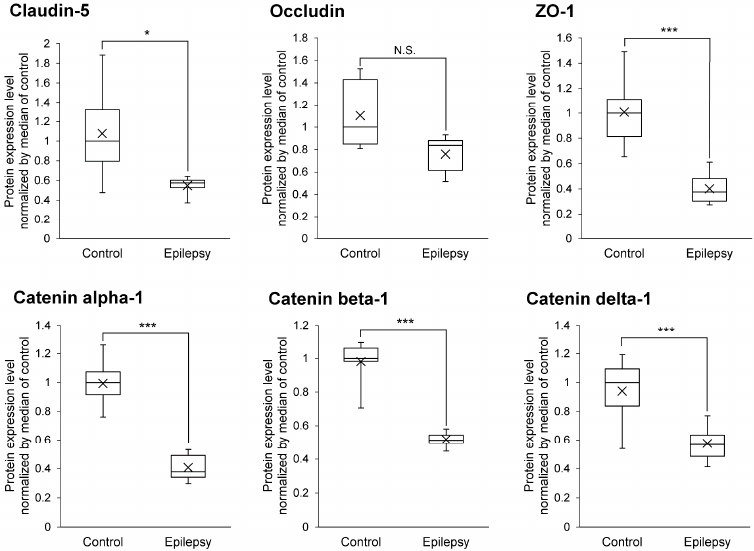
Figure 3. Protein expression level of tight junction and adherence junction proteins in epileptic brain capillaries compared to controls. Brain capillaries were isolated from focal sites in six epilepsy patients and five normal brains; tryptic digests were produced and subjected to SWATH analysis. The band inside the box represents the median, and the box’s bottom and top indicate the first and third quartiles, respectively. The whiskers indicate the minimum and maximum values of the protein levels. X plots show the average for each group. The data are normalized by median of the protein expression level in control. * BH-adjusted p value < 0.05 and *** BH-adjusted p value < 0.001, significantly different between epilepsy and control groups. N.S., not significantly different.